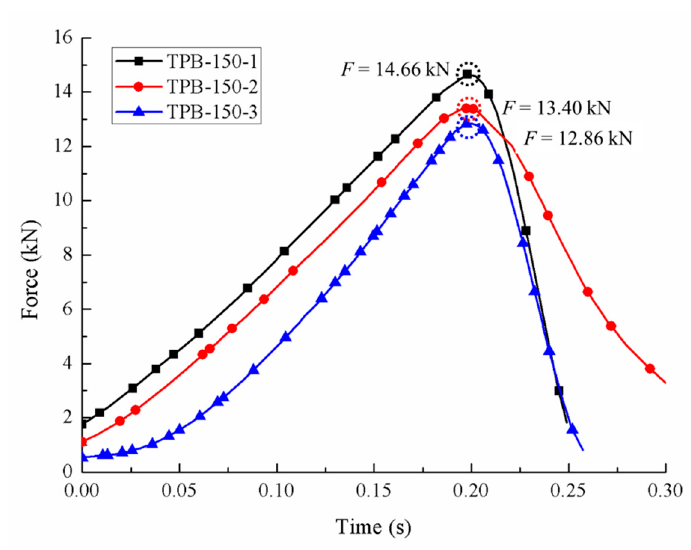
Figure 9. Force-time curves with the loading velocity of 150 mm/min.